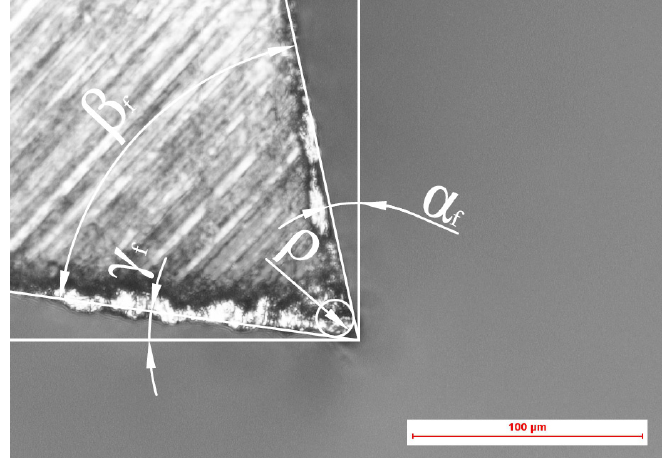
Figure 2. Methodology for measuring the cutting edge radius ρ based on a microscope image.